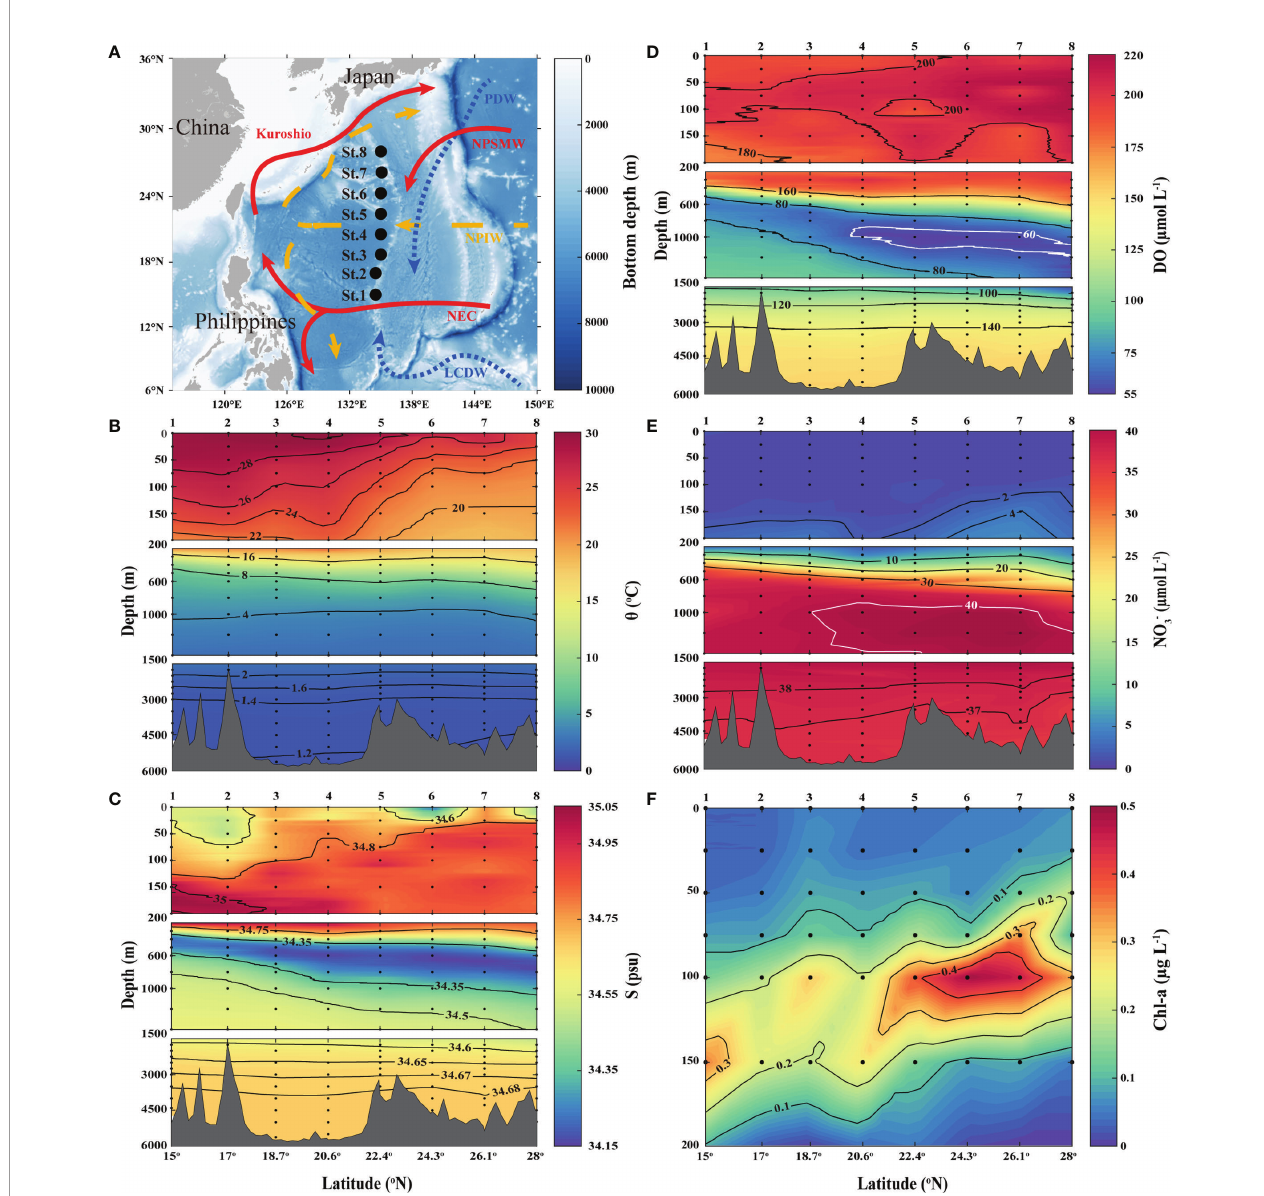
FIGURE 1 | (A) Study area and station locations in the Subtropical Western North Paci fi c Ocean (STWNPO). Different colors (white – blue gradient) represent the bathymetry information. Schematic arrows represent fl owing major currents and water masses in compliance with the surface (red and solid), intermediate (yellow and dashed), and deep (blue and dotted) layers. The vertical pro fi ling of (B) potential temperature ( q ), (C) salinity (S), (D) dissolved oxygen (DO), (E) nitrate (NO − 3 ), and (F) chlorophyll- a (Chl- a ) along the latitudinal transects in the STWNPO. The black dots indicate sampling locations/depths, and the black/white solid lines represent the contour lines of each parameter. The numbers (1 – 8) at the top of (B – F) are the station numbers. This fi gure is also available with a gray color version in Supplementary Materials